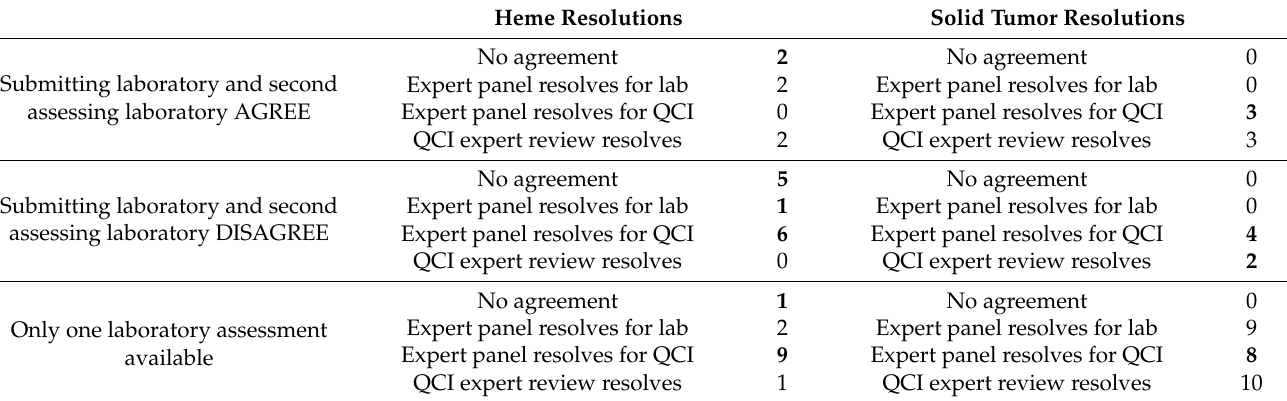
Table 3. Discrepancies among expert